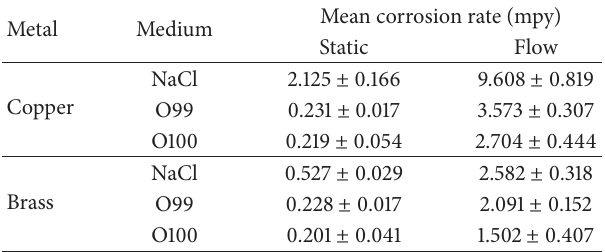
Table 3: Mean corrosion rate of copper and brass by mass loss